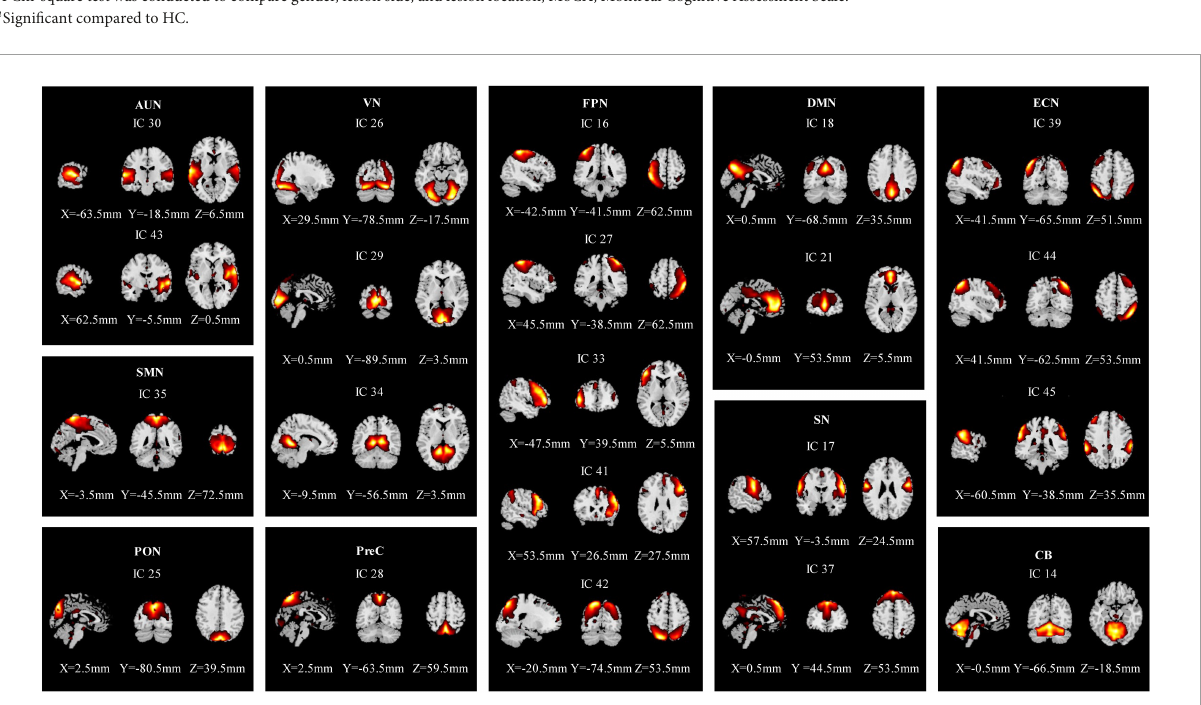
FIGURE2 Spatial maps of the 21 independent network components. They were divided into 10 functional networks based on their anatomical and functional properties, including the auditory network (AUN), the visual network (VS), the sensorimotor network (SMN), the occipital network (PON), the precuneus network (PreC), the default mode network (DMN), the frontoparietal network (FPN), the executive control network (ECN), the salience network (SN), and the cerebellar network